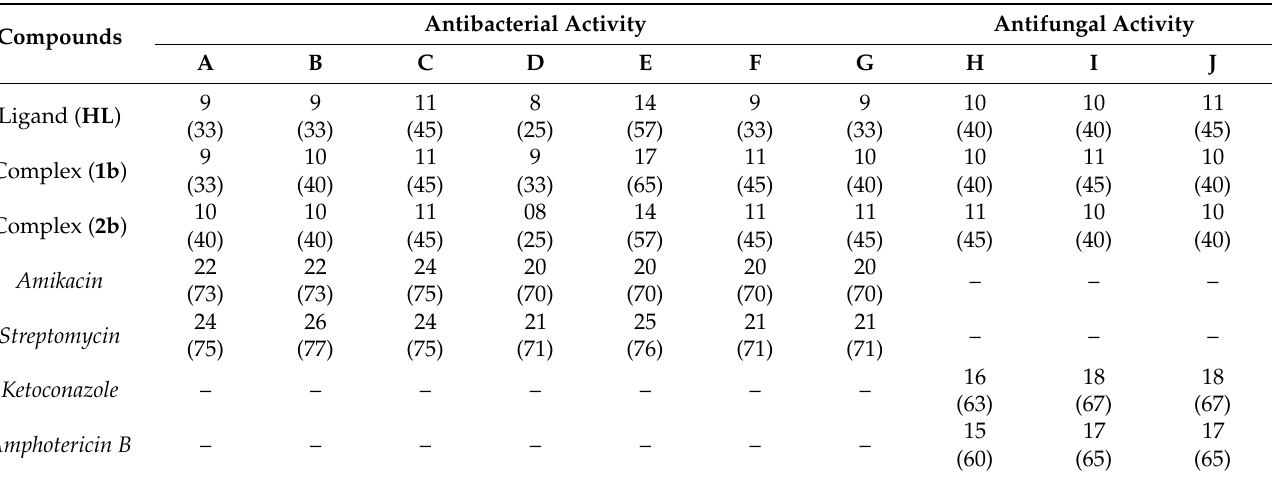
Table 8. The evaluation of Antimicrobial activities (diameter of clear zone inhibition in mm) (Inhibi- tion %) of the ligand ( HL ) and its complexes ( 1b – 2b ).